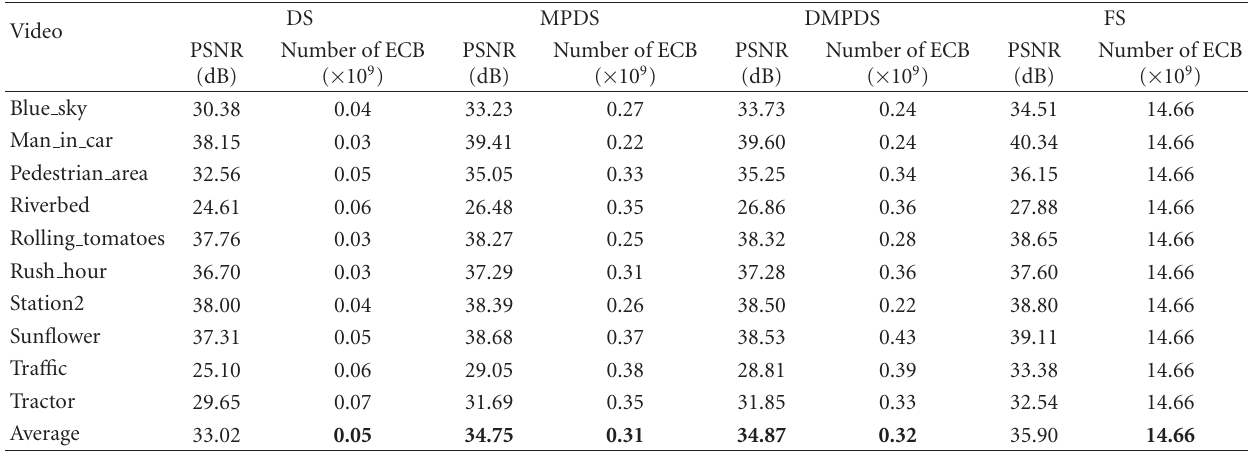
Table 1: Quality and computational cost results for the DMPDS Algorithm.